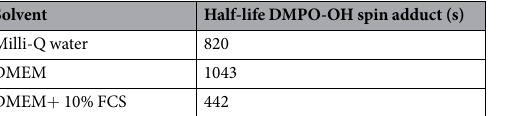
Solvent Half-life DMPO-OH spin adduct (s)